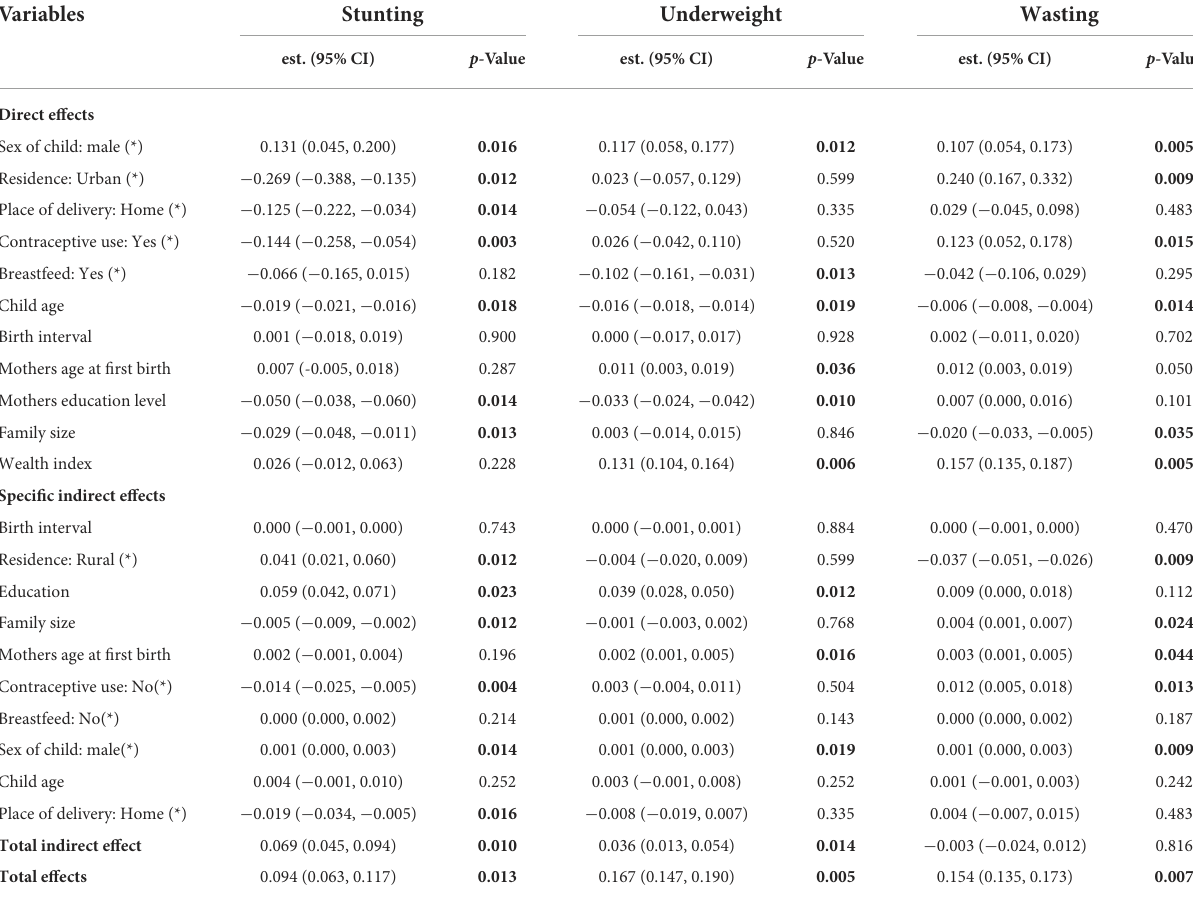
TABLE 2 Parameter estimations of direct, indirect, and total effects of wealth index on stunting, underweight, and wasting. Variables Stunting Underweight Wasting